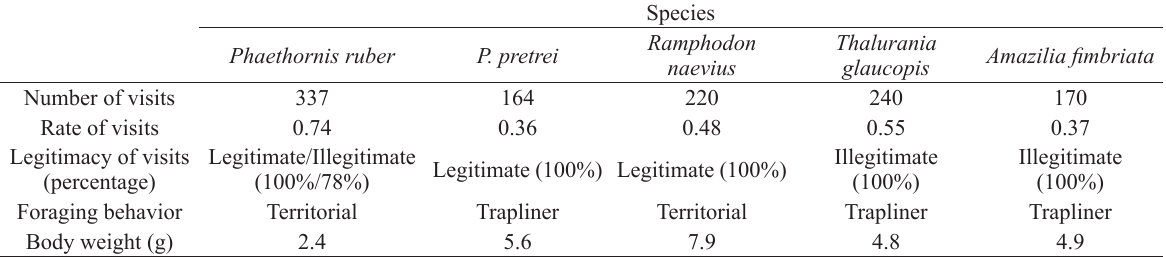
Number of registered visits (n=1131), visitation rate (number of visits/hour (0h50m of each hour)), type of visit, foraging behavior, and body weight of the flower-visiting hummingbirds in 10 individuals of the plant Dahlstedtia pinnata (Benth.) Malme. monitored between August 2010 and August 2011, in Pedra Branca State Park, Rio de